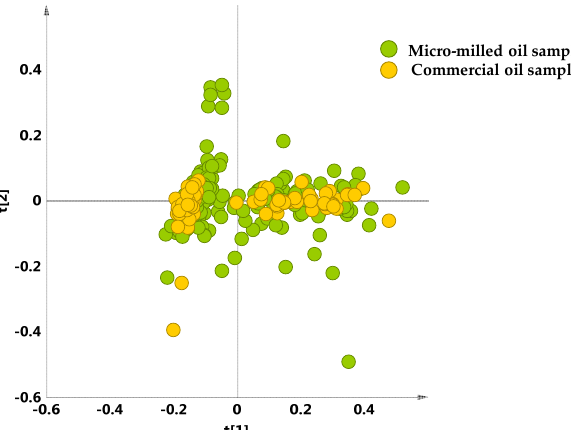
Figure 8. PCA t[1]/t[2] scores plot (t[1] and t[2] explain 59.5% and 13.2% of the total variance, respectively) for micro ‐ milled olive oil samples and commercial bottled protected geographical indication (PGI) EVOOs, supplied by Certified Origins Italia srl.